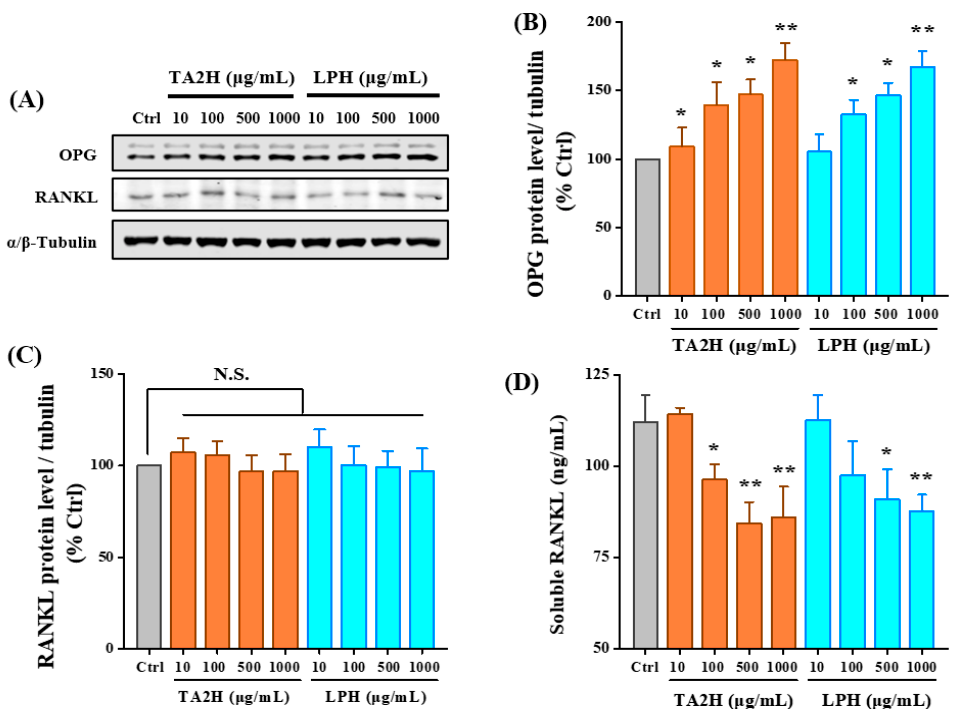
Figure 5. Effects of whey protein hydrolysates (TA2H and LPH) on OPG and RANKL expression in preosteoblast cells. MC3T3-E1 cells were seeded on six-well plates and were treated with growth medium containing 0 (control group), 10, 100, 500, and 1000 μ g/mL of TA2H and LPH for 72 h prior to being lysed and immunoblotted for the Western blotting analysis of ( A ) OPG and ( B ) RANKL. The expression of α / β -tubulin was used as the loading control, and the fluorescence intensity of immunoblots was measured. All bands are shown in ( C ). The culture medium was evaluated for ( D ) soluble RANKL contents. Data are represented as the mean ± SEM, n = 3. * and ** indicated p < 0.05 and p < 0.01, as compared to the control group. N.S. indicated p >